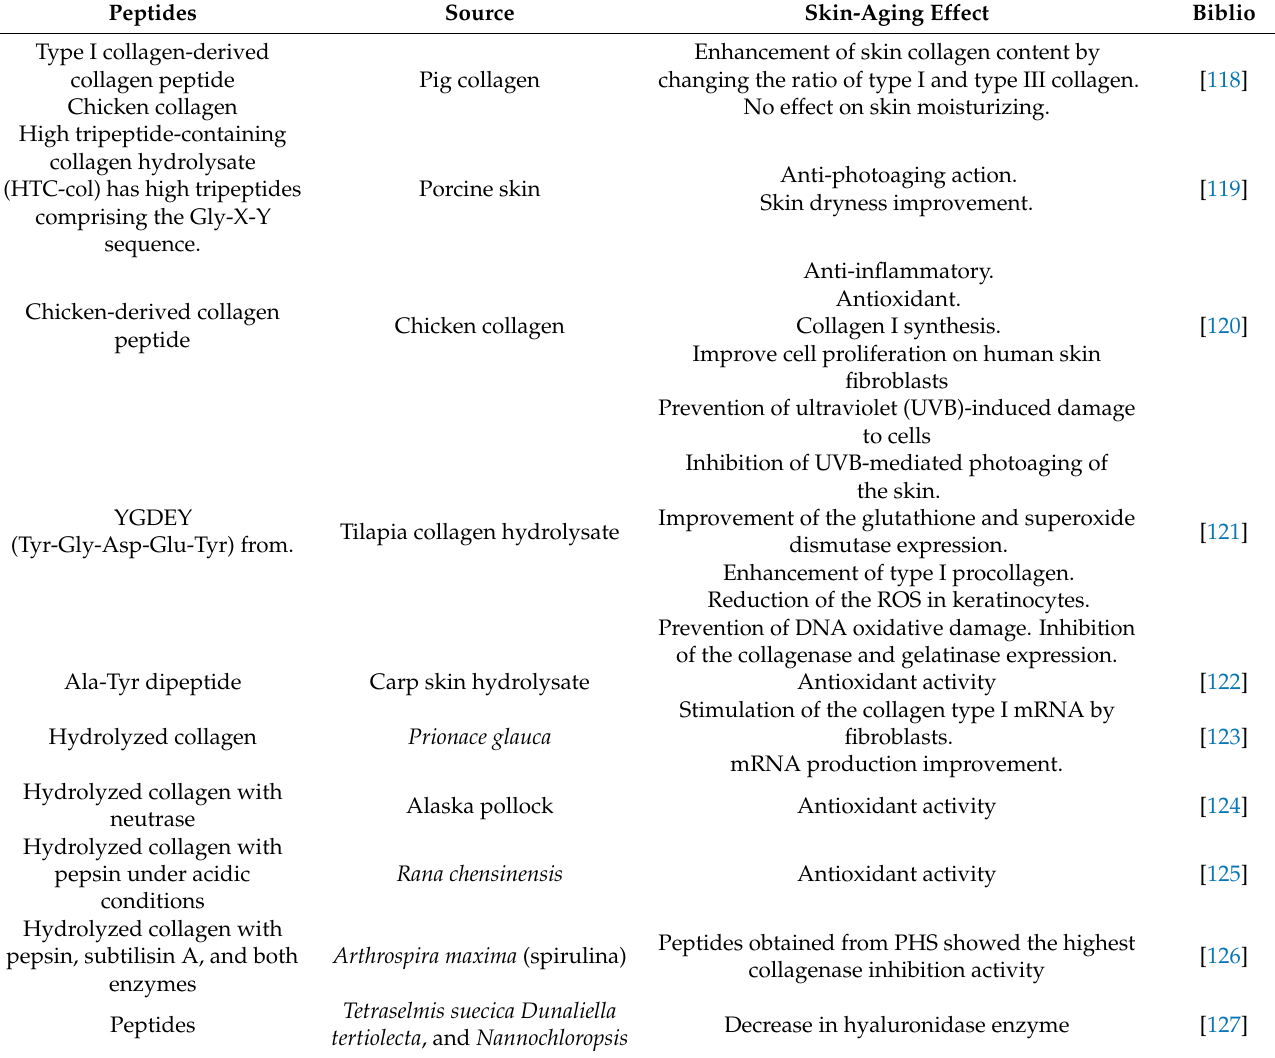
Table 1. The anti-skin-ageing effect of collagen peptides made from a natural source.